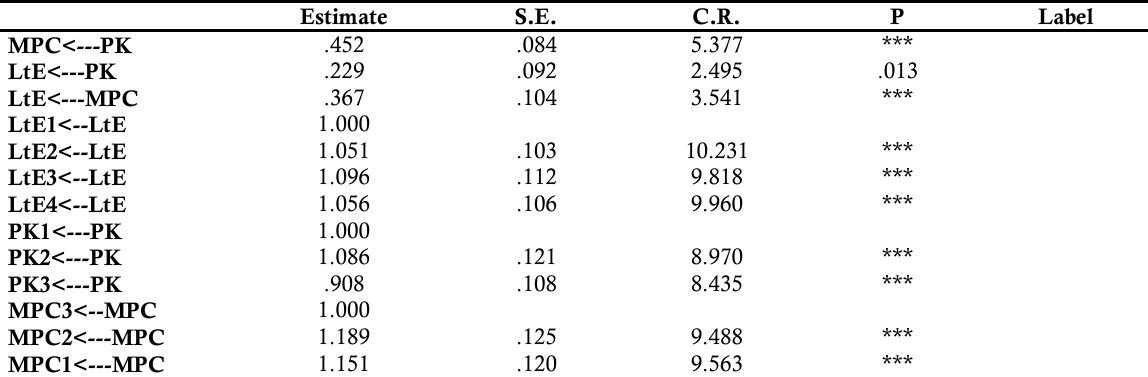
Table 2. Maximum Likelihood Estimates Regression Weights: (Group number 1 - Default model)